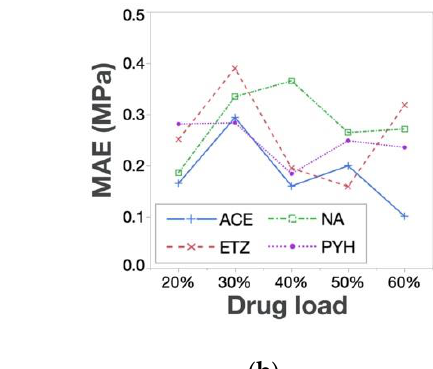
Figure 6. TS Prediction accuracy—( a ) R 2 and ( b ) mean absolute error (MAE).